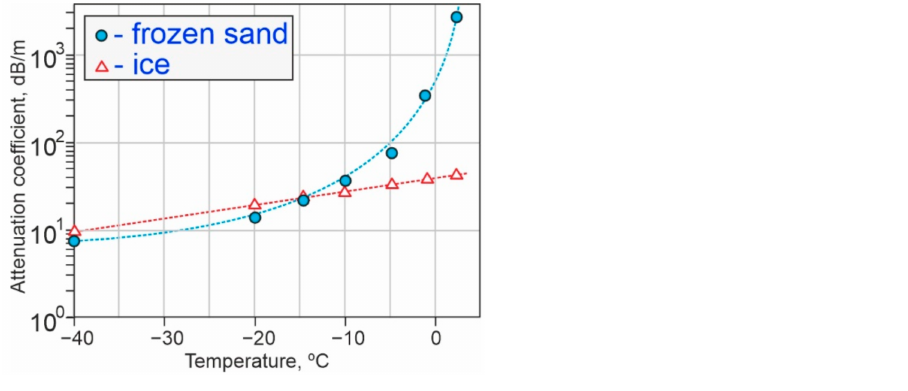
Figure 9. Temperature dependence of ultrasound attenuation (1 MHz) in frozen sand and ice modified from